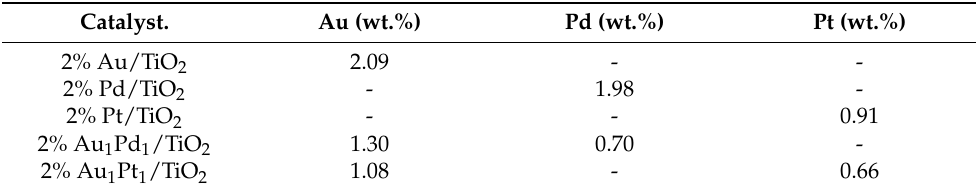
Table 1. ICP-OES analysis of the prepared